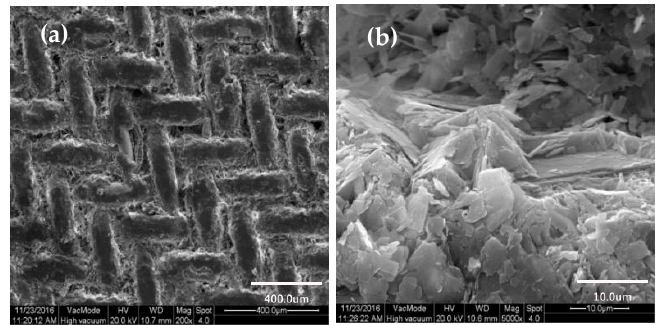
Figure 6. SEM image of the surface morphology of the etching and oxidation copper mesh after modification of SA. ( a ) at a low magnification (200×); ( b ) at a high magnification (5000×).